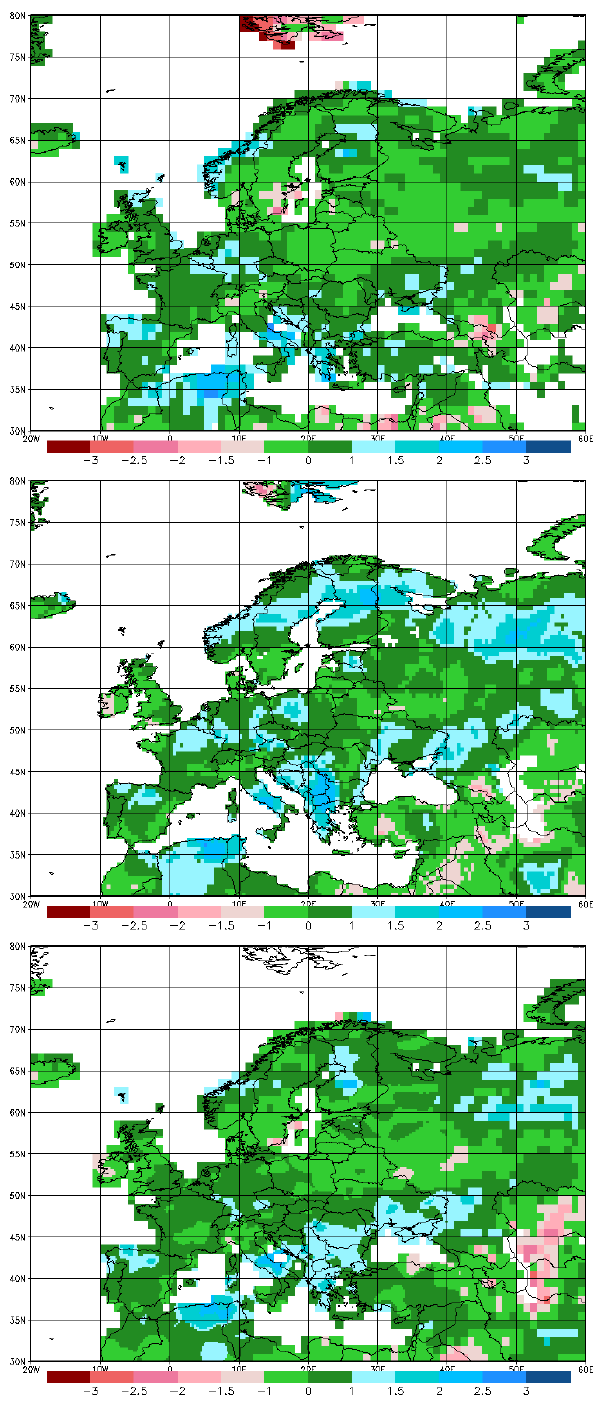
Figure 13. Comparison of the GPCC-DI (top), SPEI (middle) and SPI-EDO (bottom) with 1-month aggregating interval for Jan- uary 2003. The color scale is the same as in Fig.